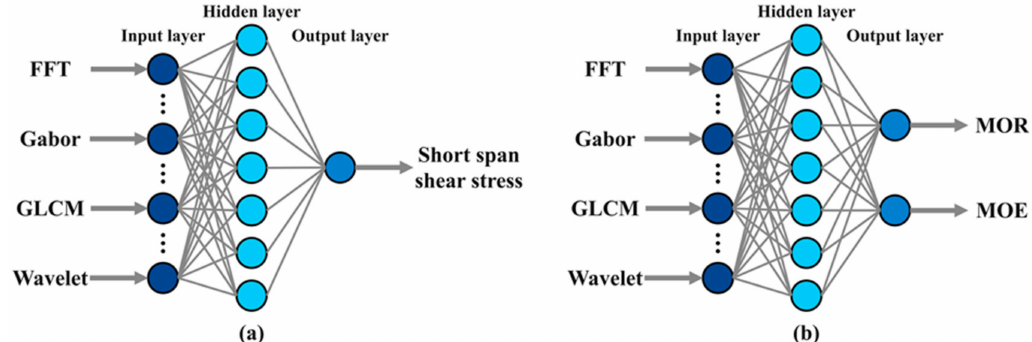
Figure 2. Schematic diagram of the ANN model for the mechanical properties of ( a ) short-span shear stress; ( b ) MOR and